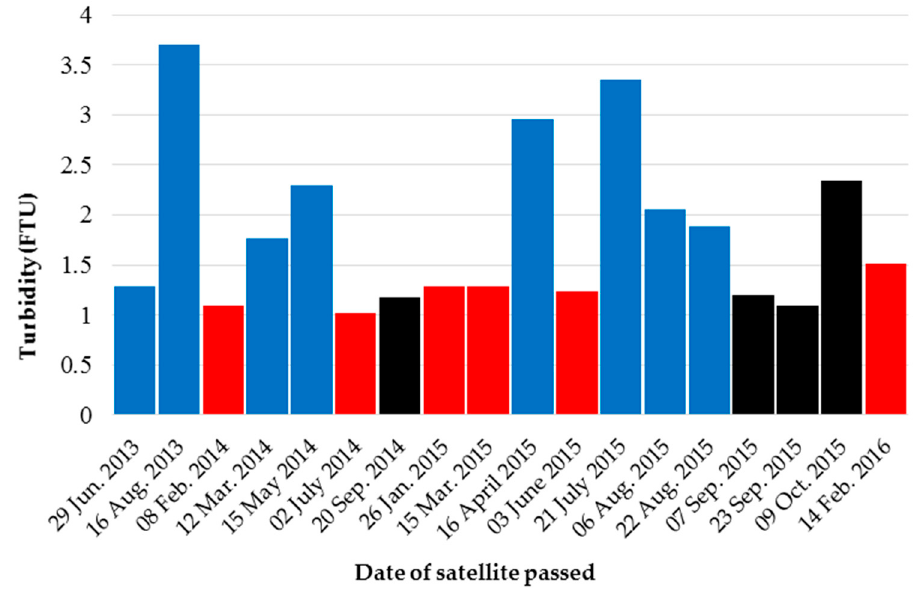
Figure 9. Landsat 8 OLI extracted mean turbidities in Cam Ranh Bay and Thuy Trieu Lagoon from 2013 to 2016 in both dry and rainy seasons (blue for shortly after rainfall in dry season, red and black for dry and rainy seasons, respectively).